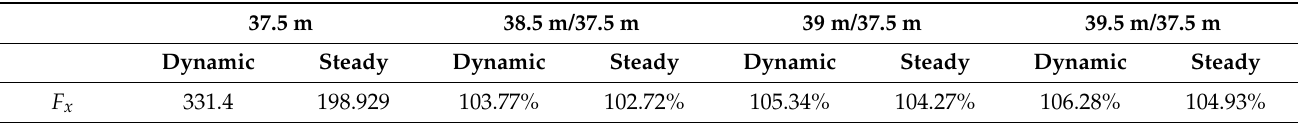
Table 17. The ultimate thrust force at hub.